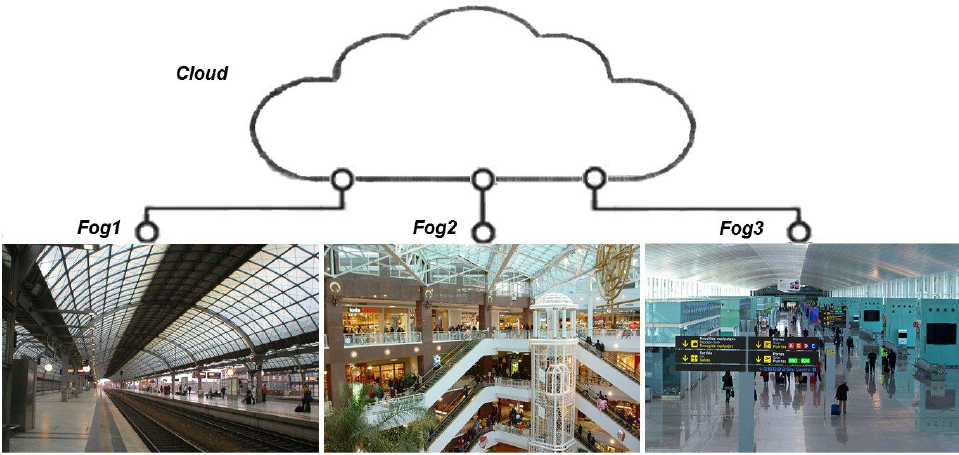
Figure 9. Managing multiple fogs in a smart city